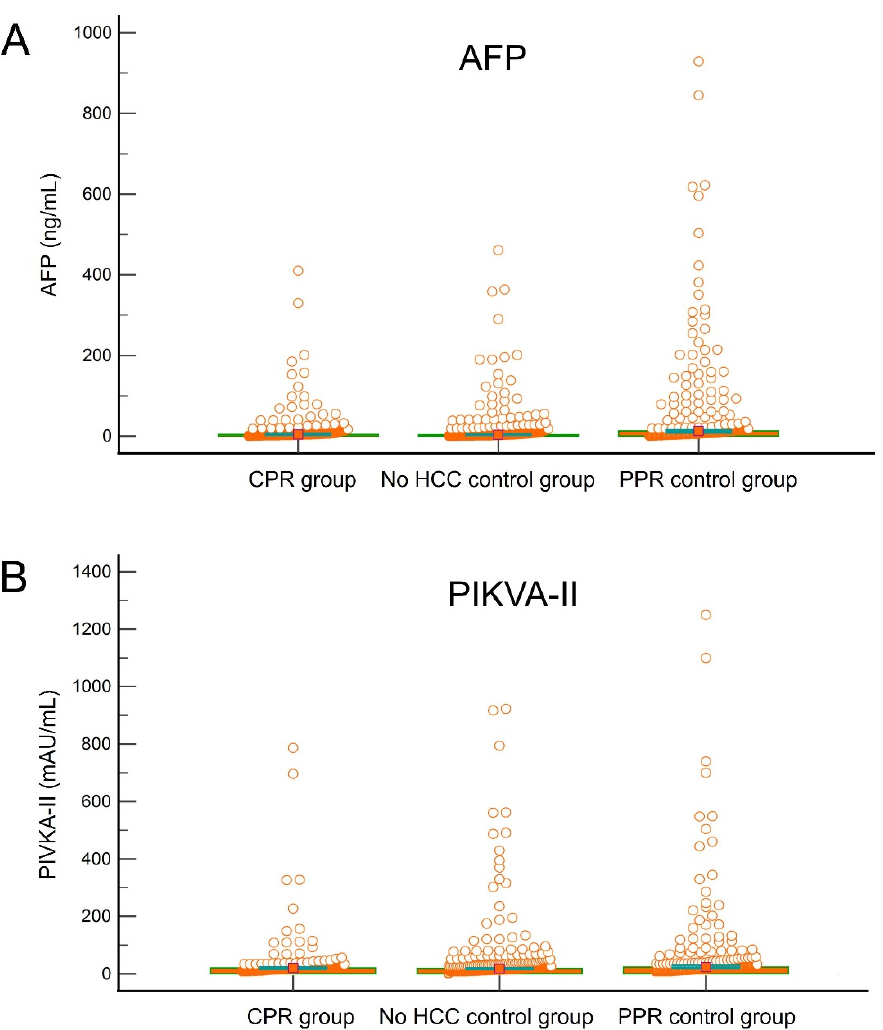
Figure 3. Comparison of α -fetoprotein (AFP; ( A )) and protein induced by Vitamin K absence or antagonist-II (PIVKA-II; ( B )) expression between the study patients with hepatocellular carcinoma of complete pathological response (CPR), control patients without hepatocellular carcinoma and partial pathological response (PPR) control group. Bars indicate the median values.